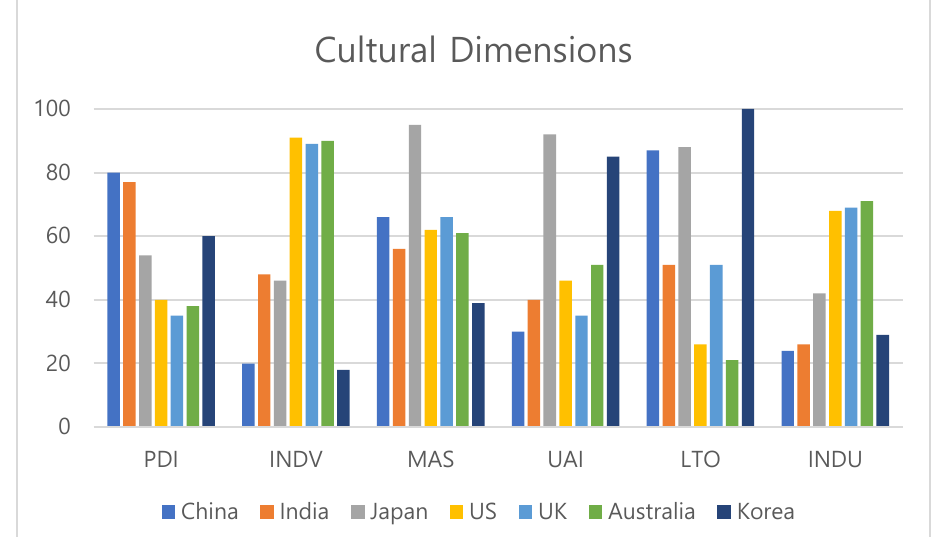
Figure 1. The value of the cultural dimensions for each country.